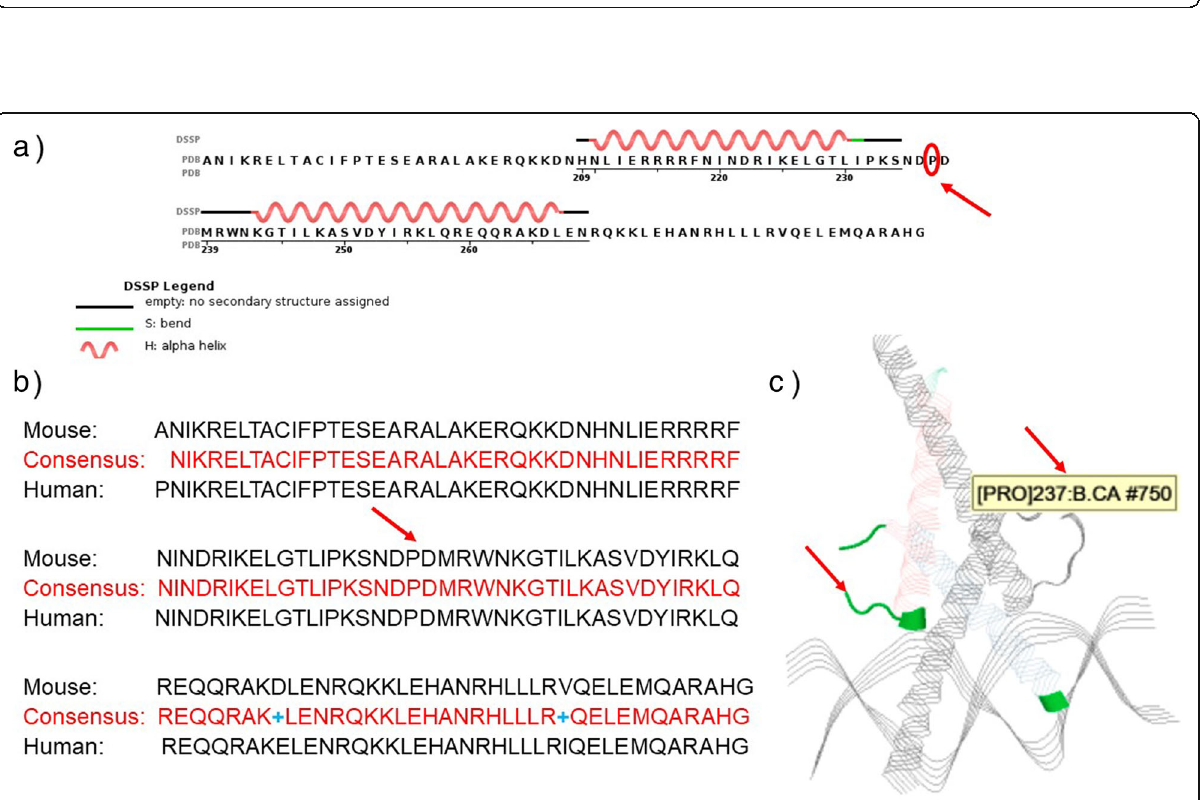
Fig. 4 Structural Characterization of the P338 residue. The mouse bHLH amino acid sequence ( a ) used for depicting the crystal structure of MITF bound to DNA showing the position of the corresponding P338 residue (red circle and arrow) is highly identical to the human sequence ( b ). The position of the proline residue at position 338 (referred to as Pro 237) is to the outside of the interface of the dimerization interface between two molecules of the mouse MITF bHLH domain ( c ). (adapted from